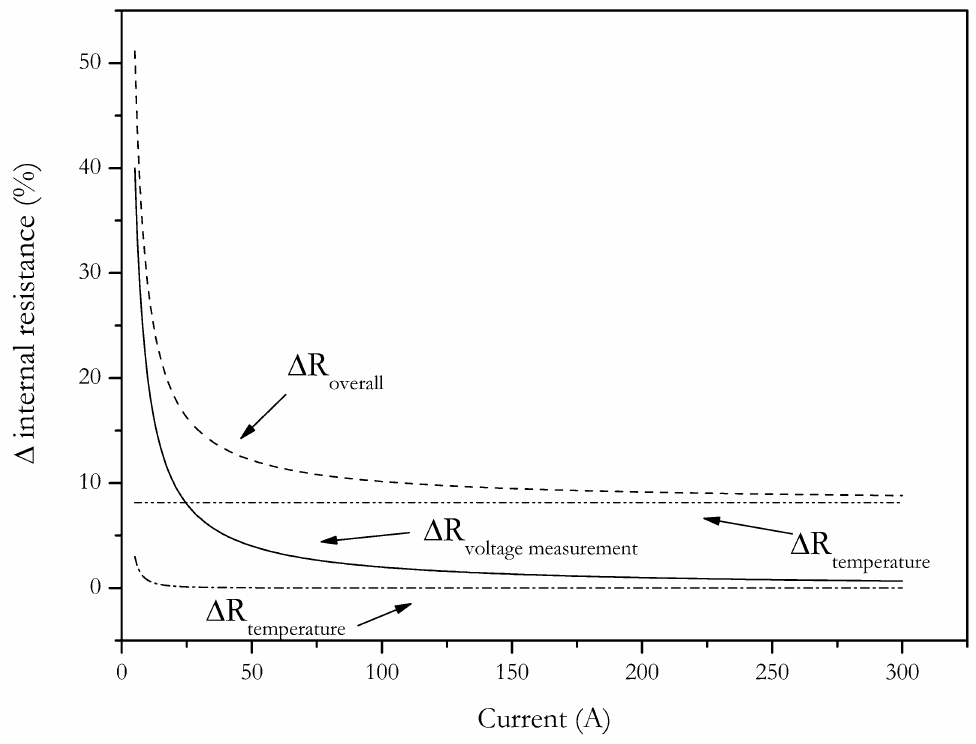
Figure 5. Accuracy of internal resistance measurement in dependence of pulse amplitude calculated by error propagation law. Contributions of uncertainties of current and voltage measurement and the thermal equilibration of the battery are also